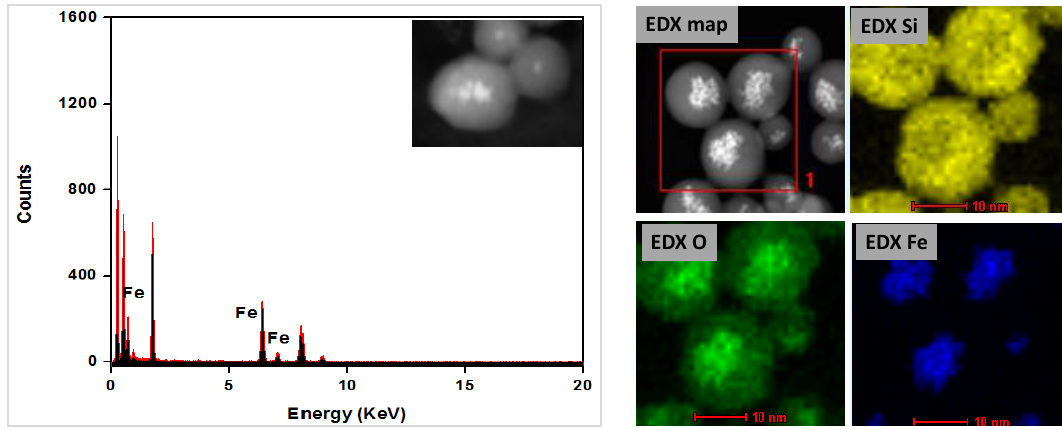
Figure 6. EDX spectroscopy (Left) and EDX mapping analysis (Right) of M-Phenylene PMO NPs .